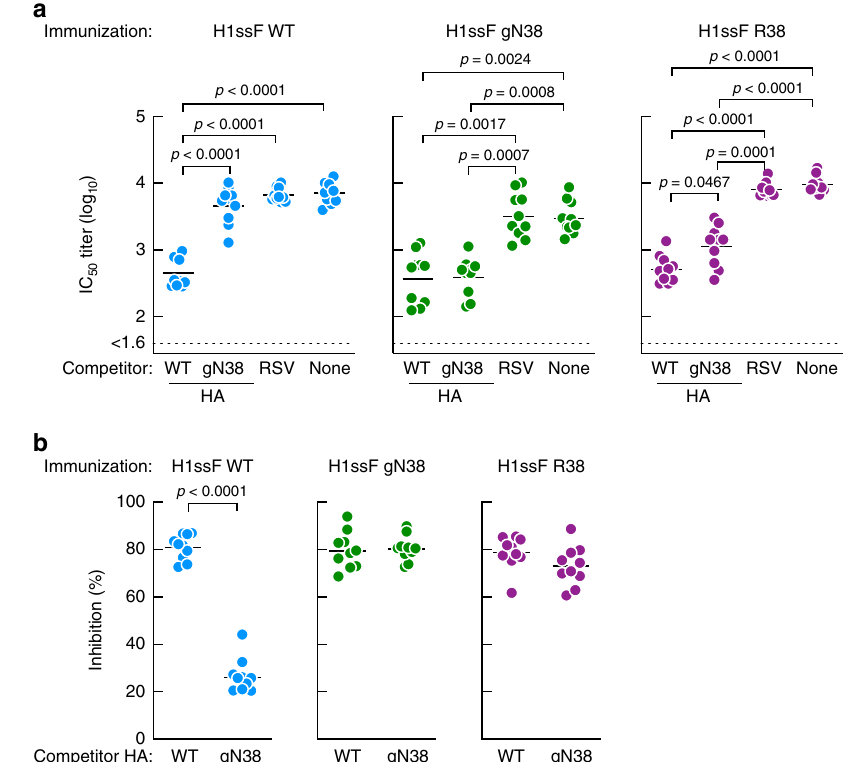
Fig. 3 Speci fi city of serum neutralizing activity elicited by H1 stem nanoparticle variants. a Serum pseudovirus-neutralization activity in the presence of competitor proteins. Immune sera were pre-incubated with either NC99 WT HA, HA gN38, or irrelevant RSV F proteins prior to evaluation of SG86 (H1N1) pseudovirus neutralization. Serum neutralization IC 50 titers were calculated in the absence or presence of competitor proteins. b Percent inhibition of virus neutralization was calculated for each competitor protein. Dotted lines indicate the lower detection limit of the assay. Data are presented as scattered dot plots with horizontal lines indicating geometric mean for each group. Statistical analysis was carried out by using nonparametric Kruskal – Wallis test with Dunn ’ s multiple comparisons. Displayed results are representative of two independent experiments. Source data are provided as Source Data fi